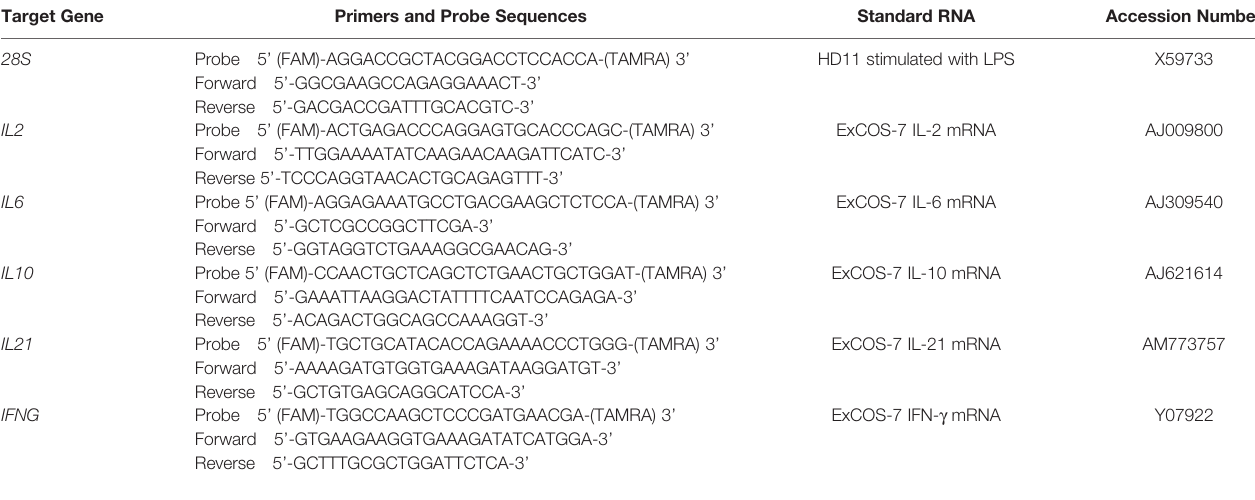
TABLE 1 | Primers and probes used in